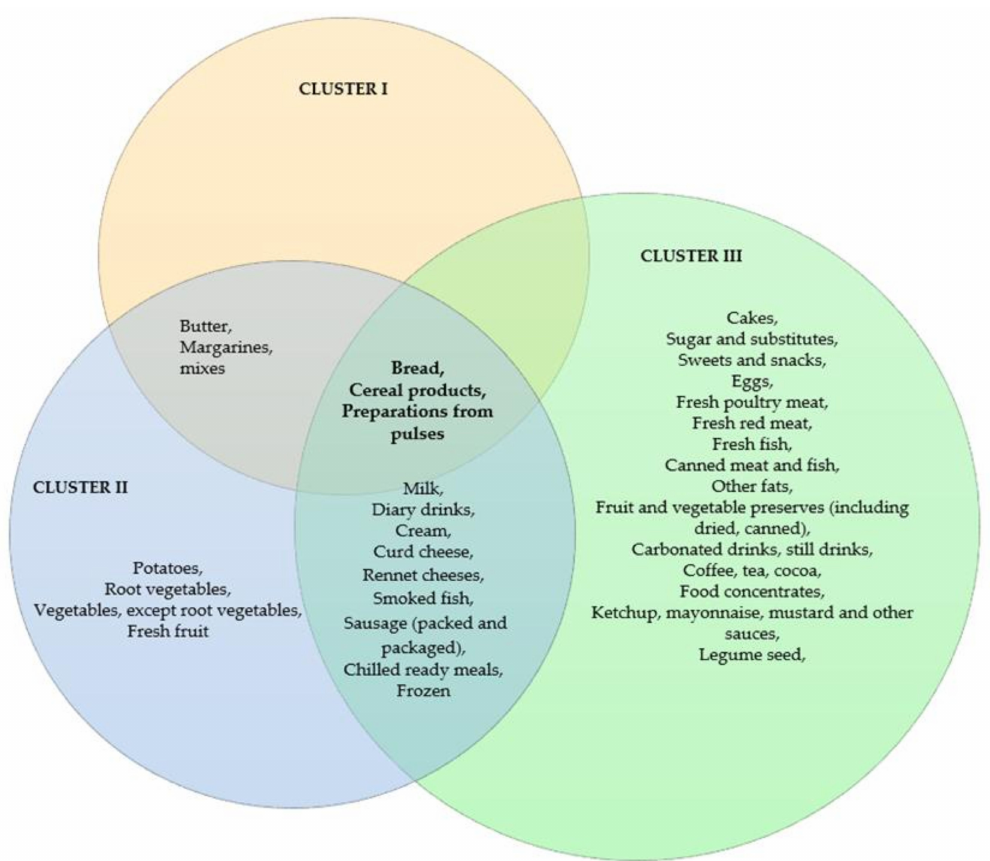
Figure 2. The highest frequency of discarding individual product groups declared by the three segments